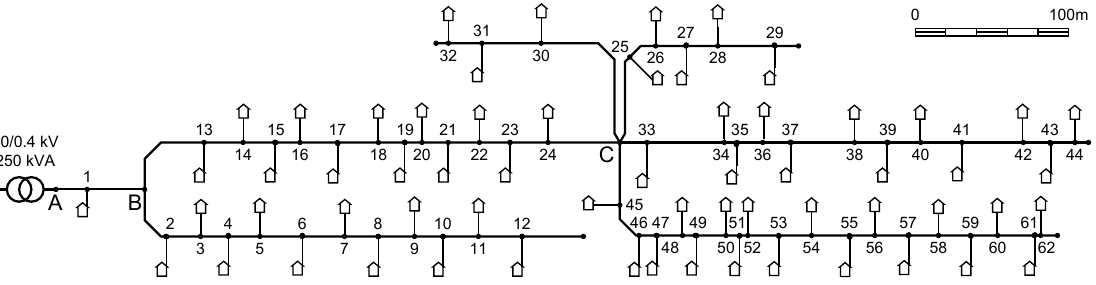
Figure 2. The network used in the simulations. All lengths are drawn to